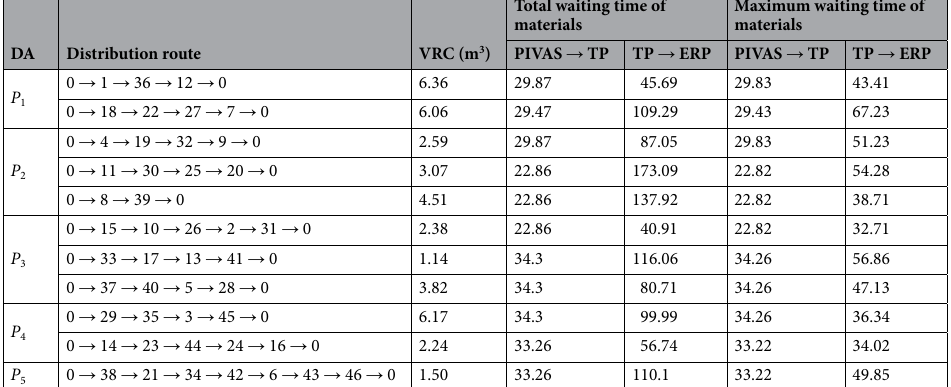
Table 5. Transit point distribution route based on HQDRO.